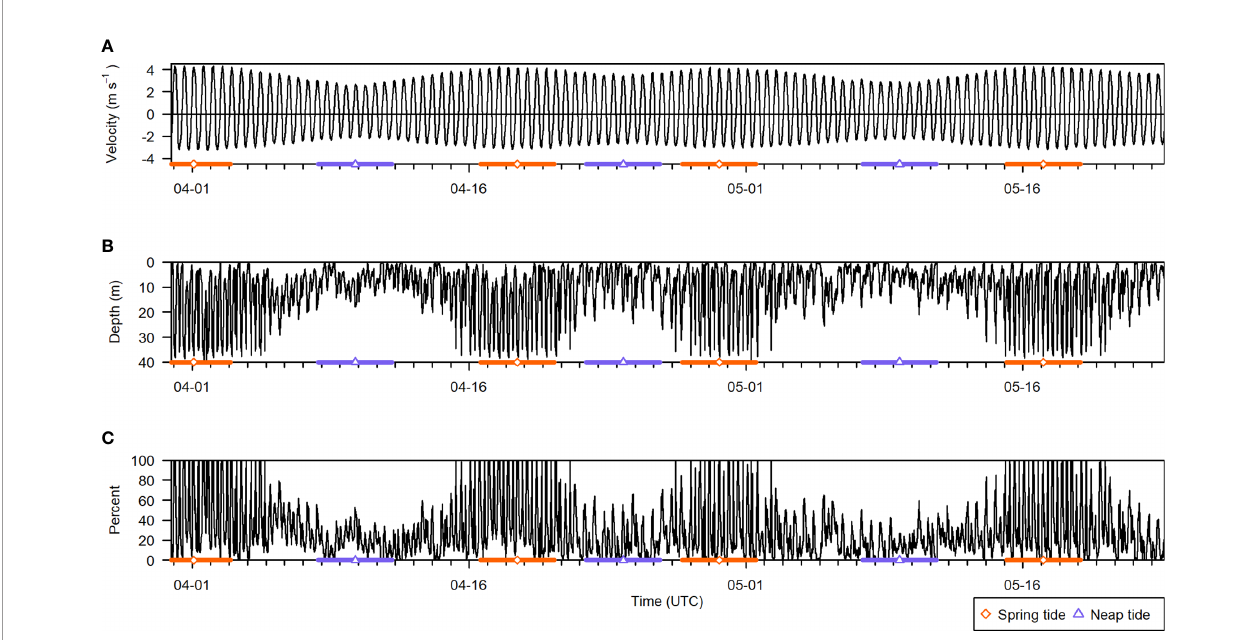
FIGURE 6 | Summary of all active acoustic recording periods from the deployment, spanning 30 March to 23 May 2018. (A) Current velocity (negative is ebb direction, positive is fl ood), (B) entrained air depth, and (C) percent of analyzable samples that were contaminated by entrained air in each recording period. The times of spring and neap tides are indicated by the orange diamond and purple triangle symbols, respectively, and the colored bars span 2 days on either side. Note that the entrained air layer depth stops at the acoustic near fi eld, located 2.4 m above the sea fl